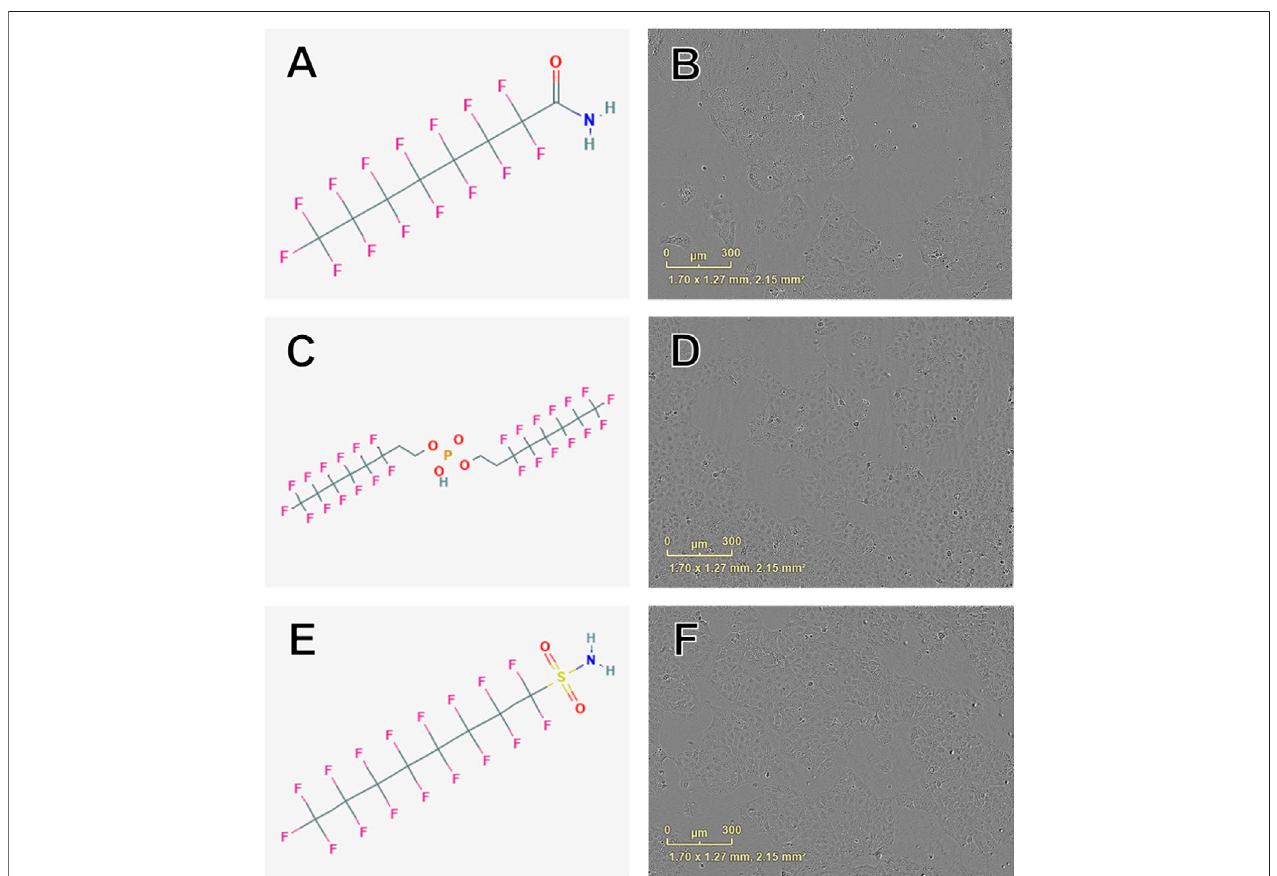
FIGURE 3| Examplesof chemical structures and corresponding phase contrast live cell images obtained from JEG-3 cells after 24 h exposure toPFAS with most pronounced effects on cellular proliferation. (A) Structure of per fl uorooctanamide (423-54-1; EC50 ± SE: 114.0 ± 35.6 µM); (B) Live cell image of cells exposed to 150 µM423-54-1; (C) Structureof6:2 fl uorotelomerphosphatediester(57677-95-9;EC50±SE:141.6±39.4 µM); (D) Imageofcellsexposedto150 µM57677-95-9; (E) Structure of per fl uorooctane sulfonamide (754-91-6; EC50 ± SE: 159.8 ± 90.0 µM); (F) Image of cells exposed to 150 µM 754-91-6. No overt cell death is apparent in (B) , (D) , or (F)